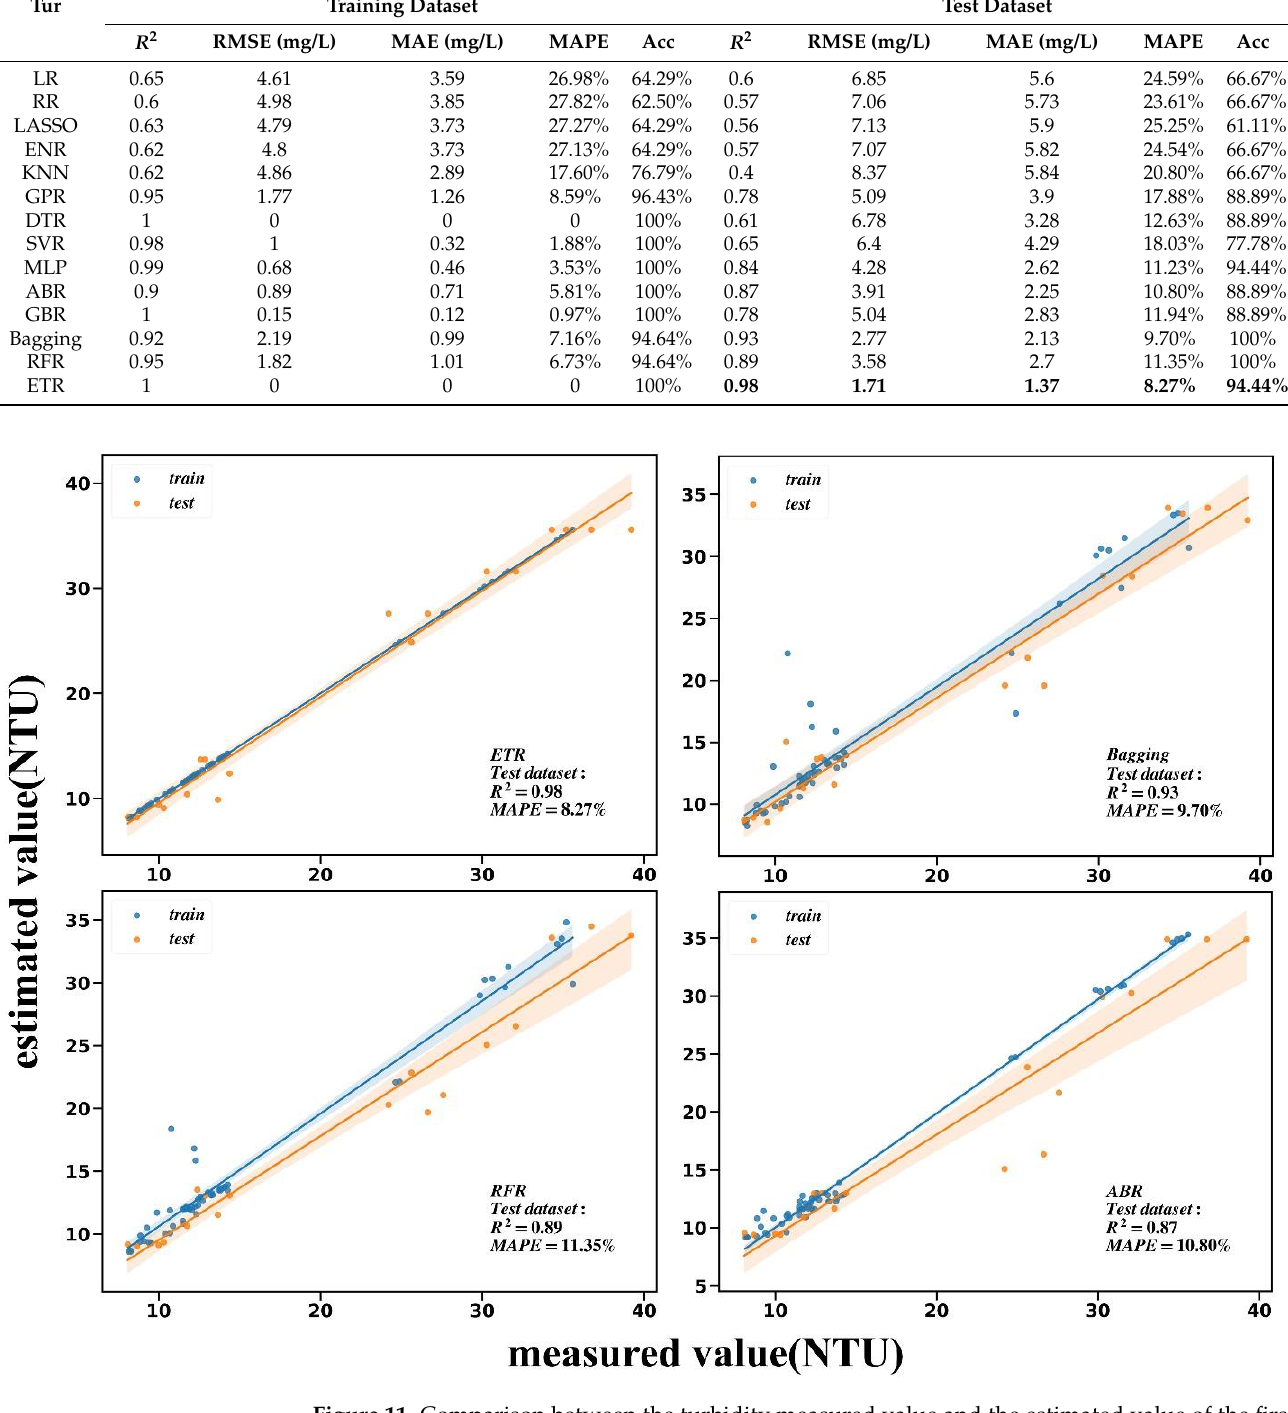
of the red band (720 nm, 750 nm). After comparison and evaluation (Table 7, Figure 12),